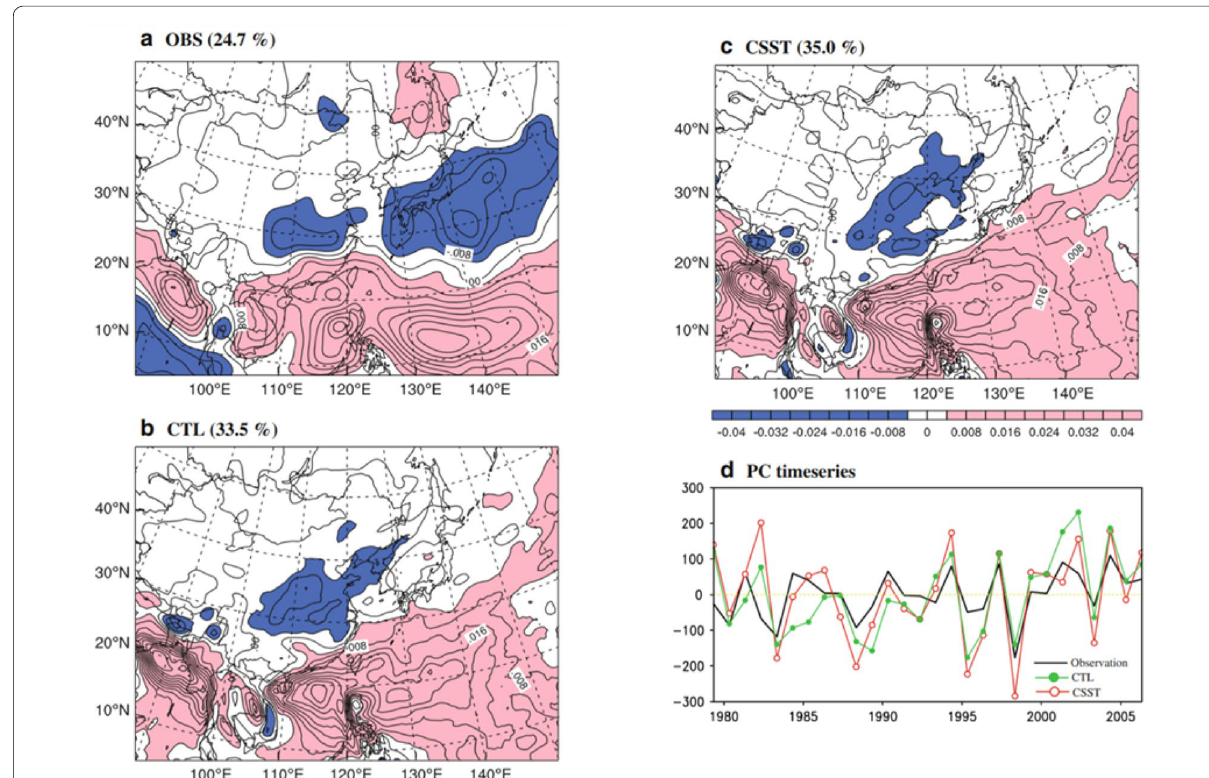
Fig. 7 a – c First mode eigenvectors and d corresponding PC time series from the EOF analysis of seasonal mean (JJA) precipitation (adapted from Cha et al.